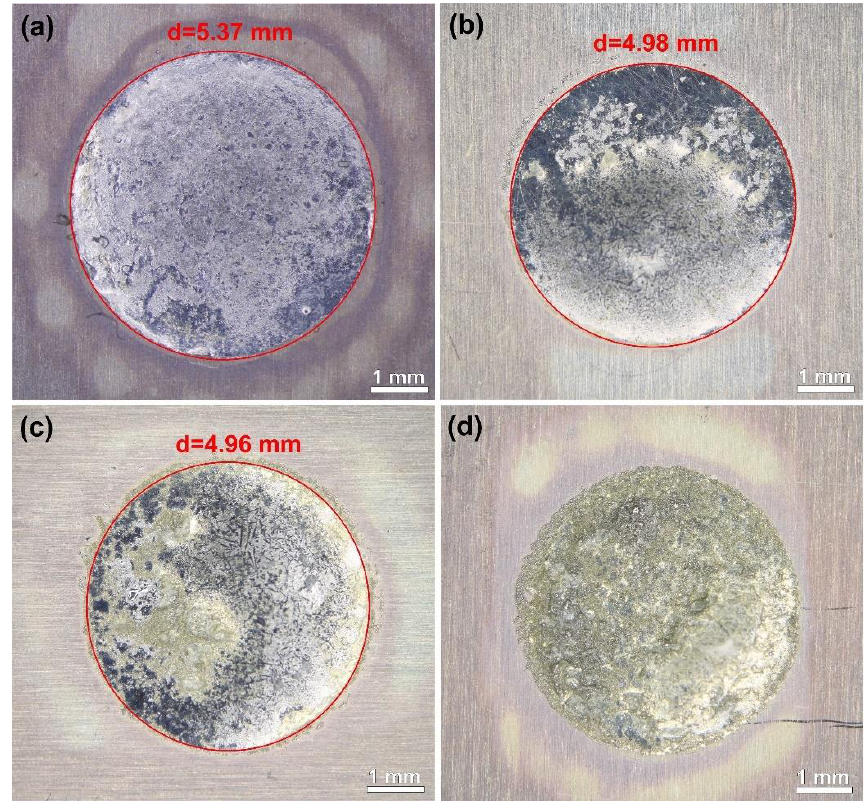
Figure 2. Results of the spreading tests: ( a ) SACX0307 reference; ( b ) SACX0307-ZnO-(200